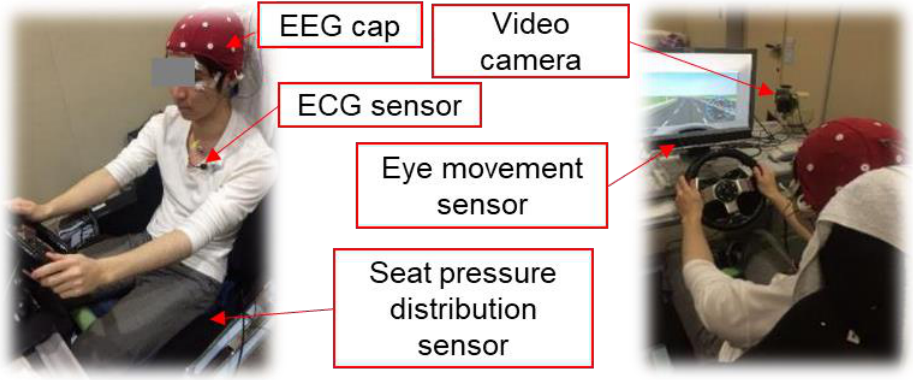
Figure 2. A view of the experimental scene.